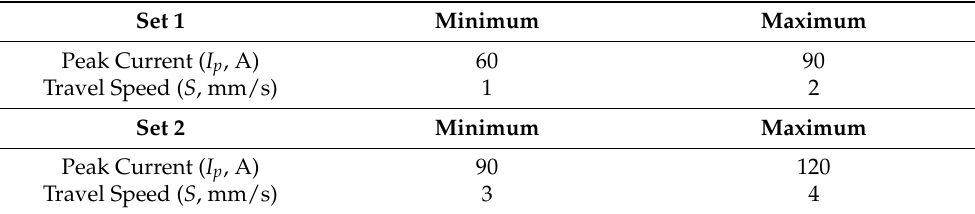
Table 4. Welding parameters divided based on the peak current ( I p ) and travel speed ( S ). Set 1 Minimum Maximum Peak Current ( I p , A) 60 90 Travel Speed ( S , mm/s) 1 2 Set 2 Minimum Maximum Peak Current ( I p , A) 90 120 Travel Speed ( S , mm/s) 3